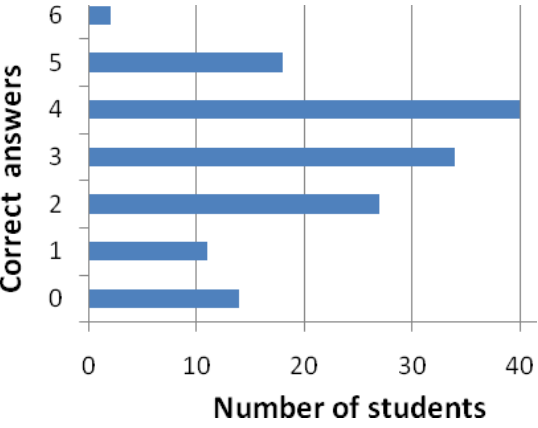
Fig.2. Number of correct answers given by a certain number of students on the on-line test As already mentioned, students could sign up for the course on-line using ATENEA. The 90 available places were filled within a fortnight, in chronological order in which the applications were received (on a first come, first served